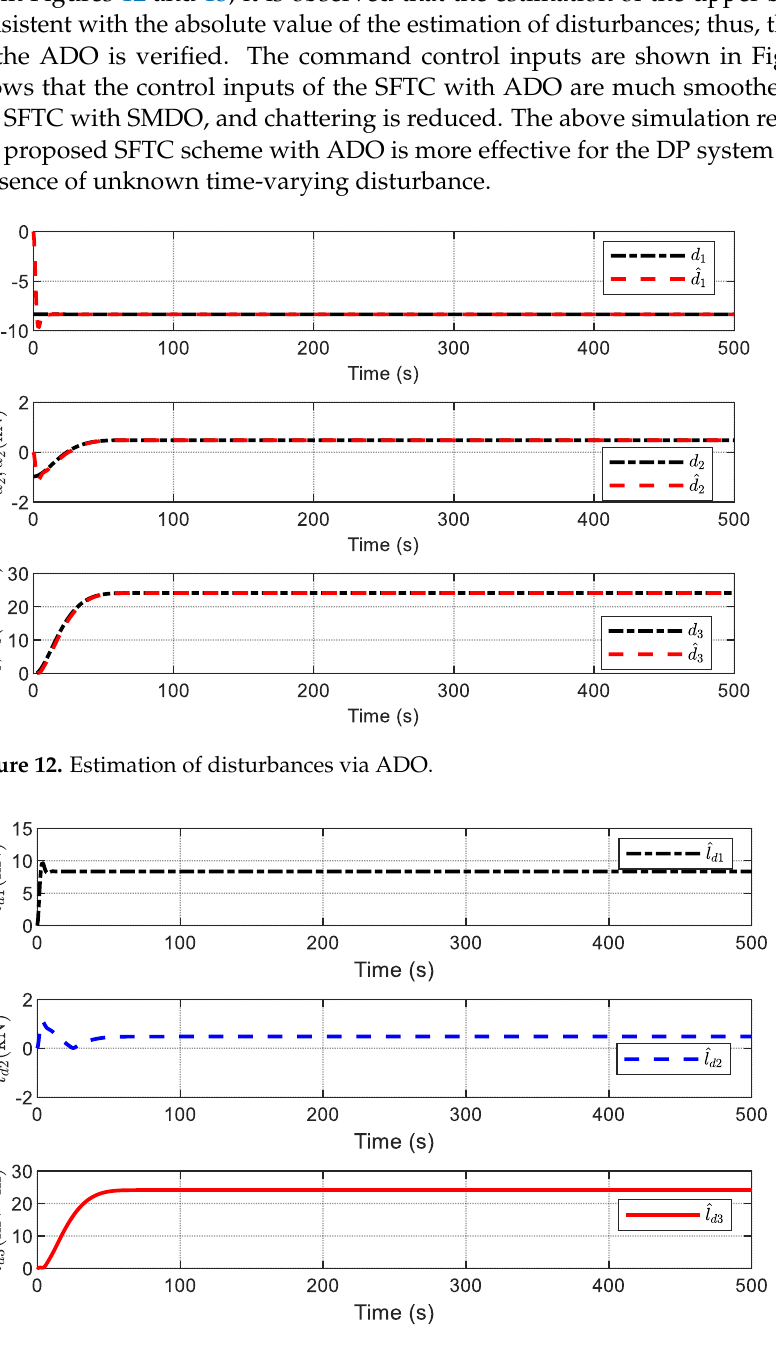
Figure 14. Comparison of control inputs.